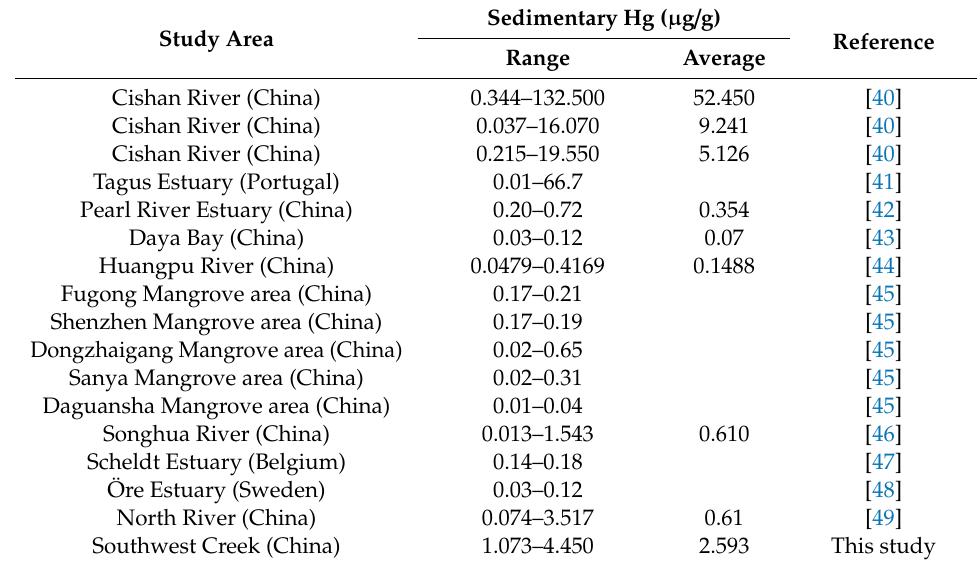
Table 3. Comparison of total mercury in di ff erent rivers